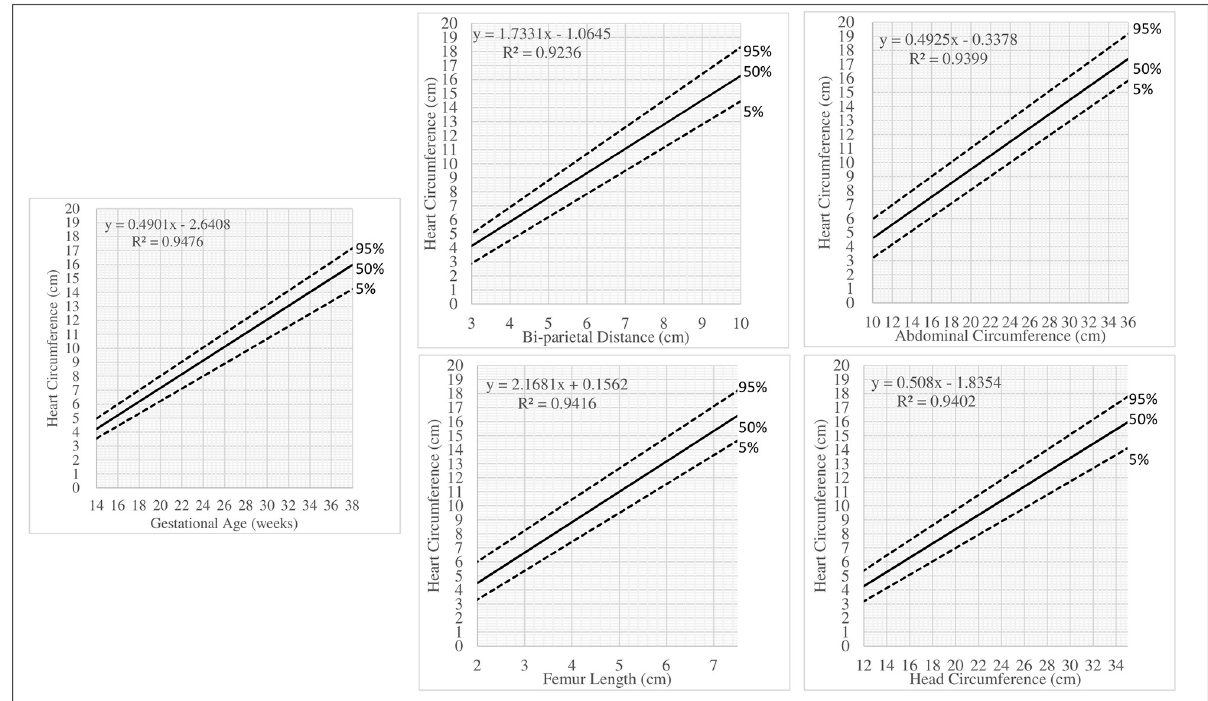
Fig 2. Centile graphs for heart circumference by estimated gestational age, bi-parietal distance, femur length, abdominal circumference, head circumference.